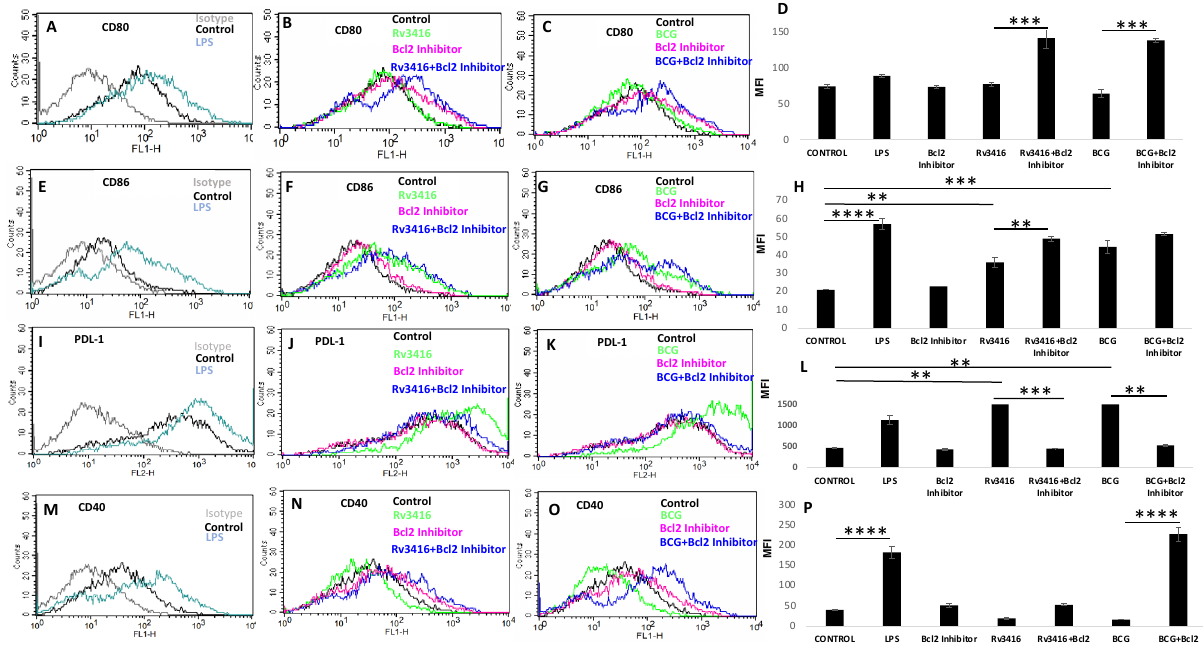
Figure 3: Inhibiting Bcl2 in Rv3416 stimulated or BCG infected BMDCs induces the expression of T cell co-stimulatory molecules on BMDCs. BMDCs were incubated with 10 μM Bcl2 Inhibitor for 1h followed by stimulation with 15 μg/ml Rv3416 or 2.5 MOI of BCG for 24h. Cells were stained either with FITC-conjugated (CD40, CD80 and CD86) or PE-conjugated (PD-L1) specific monoclonal antibodies. Grey line in Panel (A,E,I&M) represents Isotype matched control cells. Black line represents Unstimulated (Control) cells, Light blue line in Panel (A,E,I&M) indicates LPS treated cells. Green line in Panel B,F,J&N represents Rv3416 treated cells. Green line in Panel C,G,K&O represents BCG infected cells. Pink line in Panels B,F,J&N and in Panels C,G,K&O represent Bcl2 Inhibitor treated cells. Blue line in Panels B,F,J&N represents Bcl2 Inhibitor treated cells prior to Rv3416 stimulation and in Panels C,G,K&O represents Bcl2 Inhibitor treated cells prior to BCG infection. Data shows a representative image of two independent experiments. Bar chart for Panel D,H,L&P alongside the graphs represents the Mean Fluorescence Intensities (MFI) of indicated groups for all the performed experiments.. For CD80, P value between groups Rv3416 and Rv3416+Bcl2 Inhibitor is P<0.001 and between groups BCG and BCG+Bcl2 Inhibitor is P<0.001. For CD86, P value between groups Control and LPS is P<0.0001, between Control and Rv3416 is P<0.01, between groups Control and BCG is P<0.001 and between groups Rv3416 and Rv3416+Bcl2 Inhibitor is P <0.01. For PDL-1, P value between groups Control and LPS is P<0.001, between groups Control and Rv3416 is P<0.001, between Control and BCG is P<0.001, between groups Rv3416 and Rv3416+Bcl2 Inhibitor is P<0.001 and between groups BCG and BCG+Bcl2 Inhibitor is P<0.001. For CD40, P value between groups Control and LPS is P<0.0001 and between groups BCG and BCG+Bcl2 Inhibitor is P<0.0001. One way ANOVA was performed followed by Bonferroni’s multiple comparison post-hoc test with 95% confidence interval. * denotes statistical significance at P <0.05, ** denotes statistical significance at P<0.01, *** denotes statistical significance at P<0.001 and **** denotes statistical significance at